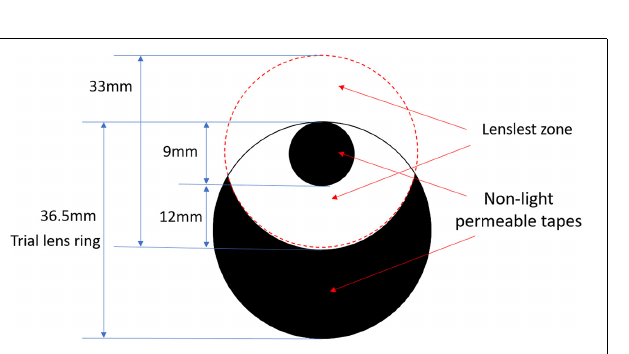
FIGURE 1 | Pictorial representation of concentric rings (left) and honeycomb (right) configurations of lenslets.